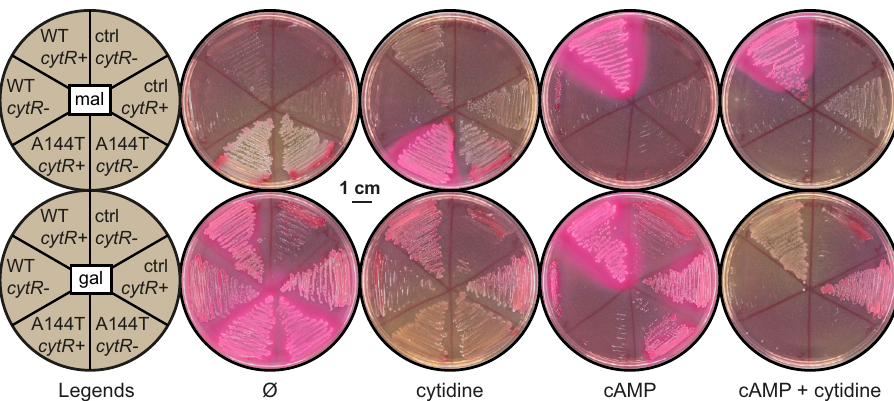
Fig. 7 Phenotypes of cytR strains on MacConkey agar. Fermentation phenotypes on MacConkey agar of MG1655 cya crp cytR ( + / − ) carrying the low- copy pSEVA plasmid expressing either wildtype crp (WT), the A144T mutant, or empty vector control (ctrl). The plates were supplied with maltose (mal) or galactose (gal) as a carbon source and supplemented with cytidine, cAMP or both, or without supplement (Ø). Experiments were repeated three times.